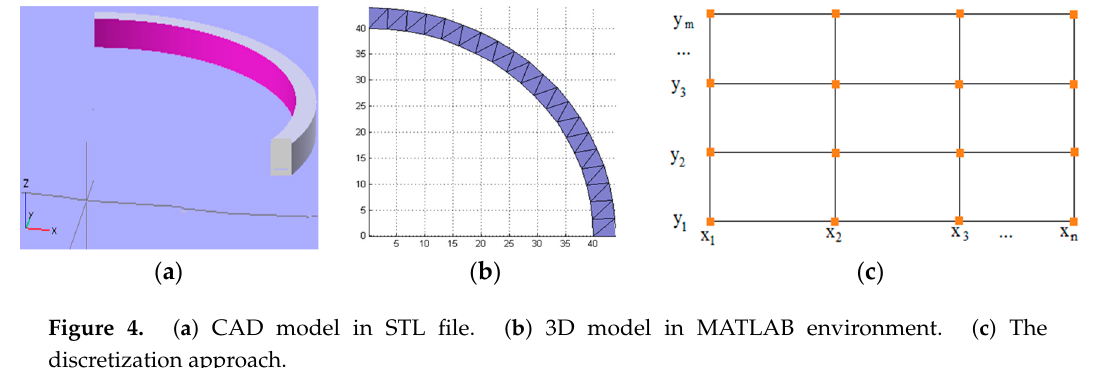
Figure 4. ( a ) CAD model in STL file. ( b ) 3D model in MATLAB environment. ( c ) The discretization ( a ) CAD model in STL file. approach. discretization